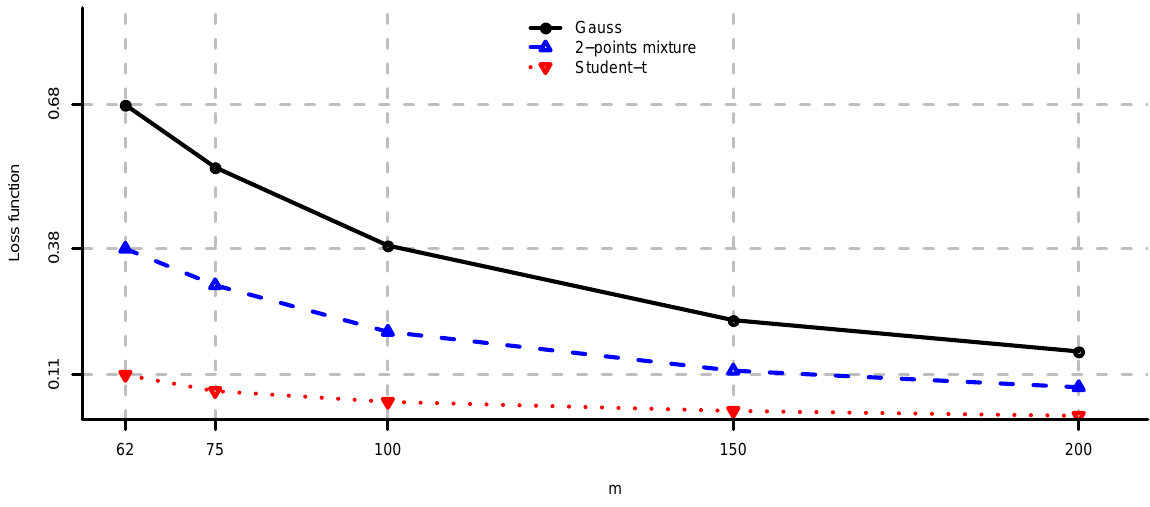
Figure 7. Adjustment factors (7) computed by simulation for N = 1000 and m = 100 , for each